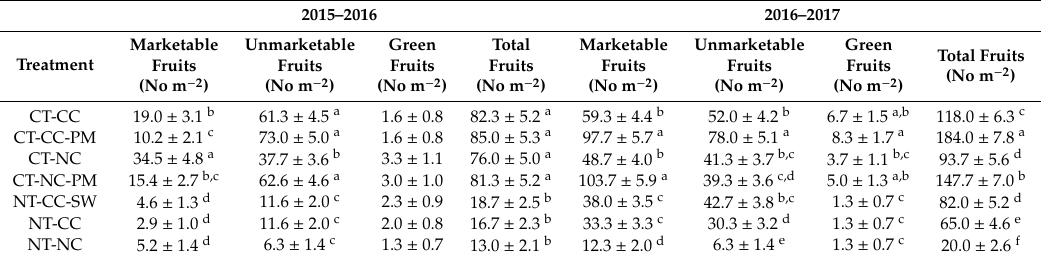
Table 4. Number of tomato fruits obtained in each system as a ff ected by tillage and cover crop